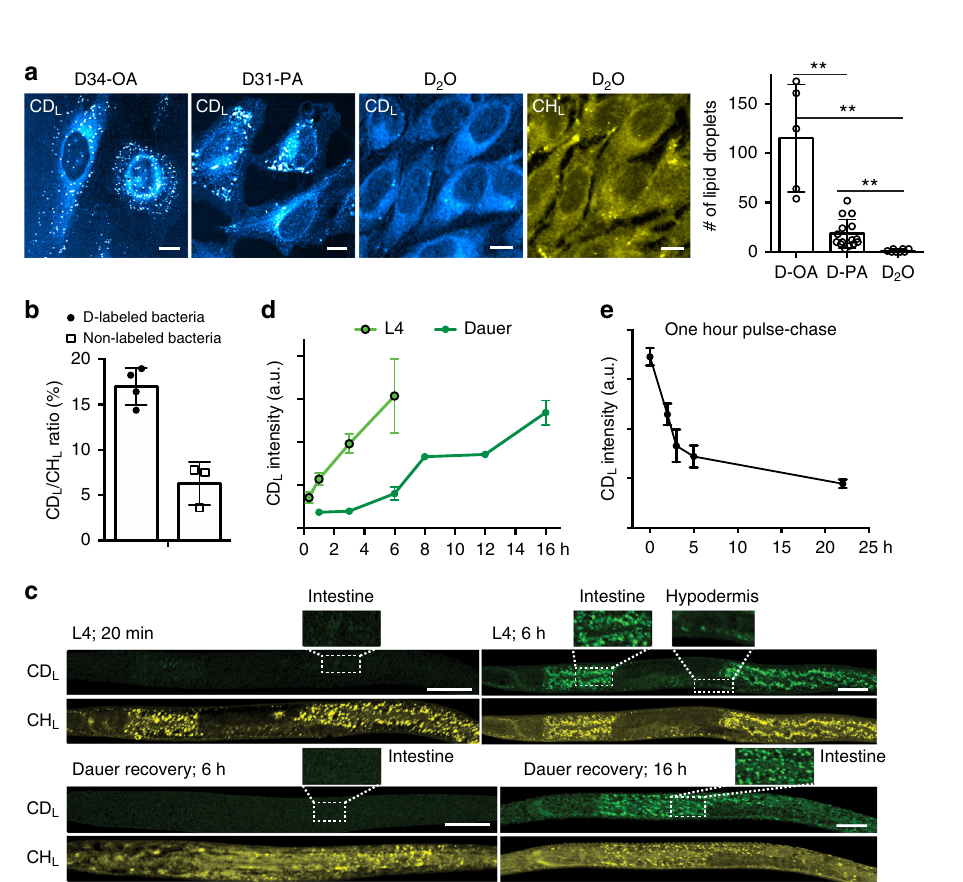
Fig. 4 DO-SRS microscopy visualizes de novo lipogenesis in cultured cells and in C. elegans . a SRS microscopic signals at 2110 cm − 1 of HeLa cells grown in DMEM with 1% FBS and 10 μ M of D34 -oleic acids (D-OA) or D31 -palmitic acids (D-PA) for 6 h, compared to the signals from HeLa cells grown in DMEM with 1% FBS and 70% D 2 O for 24 h. The numbers of lipid droplets formed in the three conditions were quanti fi ed (mean ± s.d.; N = 5 for D-OA, 15 for D- PA, and 8 for D 2 O; double asterisks indicate p < 0.01 in an unpaired t test). CH L signal for D 2 O treatment con fi rmed the presence of few lipid droplets. b SRS microscopic signal intensity ratios (mean ± s.d.) of third-stage larva grown from eggs on 20% D 2 O plates seeded with live ( N = 4) or UV-killed ( N = 3) E. coli OP50 24 h before imaging. Live bacteria were labeled by deuterium, and killed bacteria were not labeled. c Normal fourth-stage larva (L4) or dauer larva were transferred from regular NGM plates made of H 2 O to plates made of 20% D 2 O and then imaged at different time points. E. coli OP50 were seeded onto the D 2 O plates 24 h before the experiments. Scale bar = 20 μ m. d Quanti fi cation of the mean intensity over the entire worm body. e L4 animals were fi rst grown on D 2 O plates for 1 h and then transferred to H 2 O plates and imaged at different time points after the transfer. CD L mean intensity was plotted. For all C. elegans experiments, at least eight animals were imaged for each condition to calculate mean intensity; mean ± s.d. of the mean intensity is Visualizing de novo lipogenesis in mice . By adding D sebaceous glands, myelin sheath in the brain, and adipose tis- 2 O to the drinking water of mice, previous studies showed the incor- sues, showed strong CD L signal and weak CD P signal (Fig. 5 and Supplementary Fig. 4A). Because the visualization of in situ poration of deuterium into the total biomass in various mouse lipid synthesis dynamics in mouse models had been particularly organs but could not image and differentiate D-labeled lipids challenging with previous methods, which mostly capture the and proteins in situ 5 – 8 . Using DO-SRS microscopic imaging static level 35 , we aimed to demonstrate the utility of DO-SRS with macromolecular selectivity, we found that different mouse microscopy in studying the development and metabolic organs show metabolic preference to either protein or lipid homeostasis of the lipid-rich tissues and to gain new insights biosynthesis, which re fl ects their different functions (Supple- into mammalian lipogenesis. mentary Fig. 4A). For example, lipid-rich tissues, such as